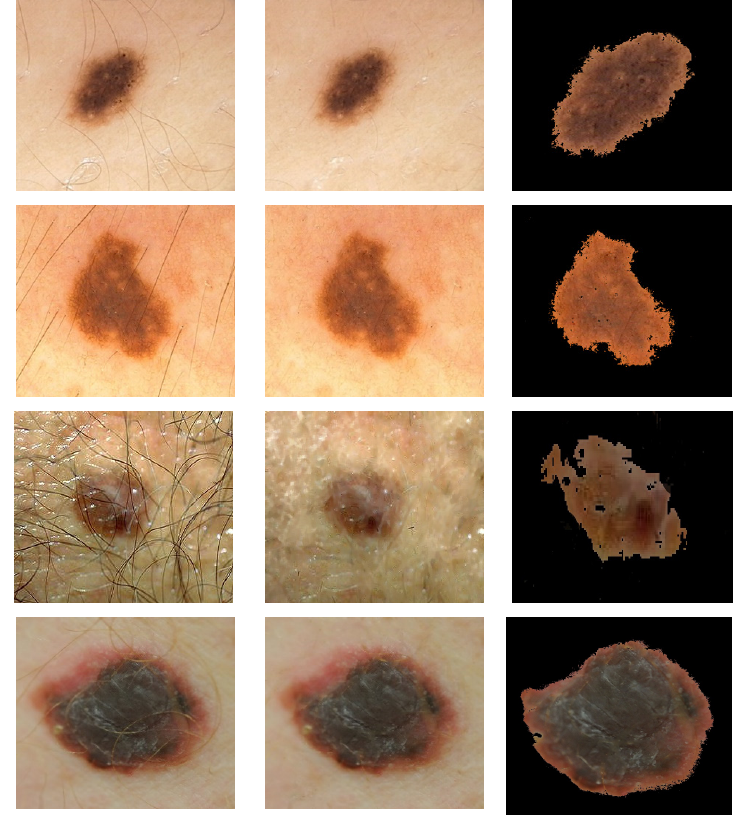
Figure 2. Illustration of pre-processing for hair removal and segmentation. Rows 1 and 2: nevi image (PH2 database). Rows 3 and 4: melanoma image (7-Point database in row 3 and Med-Node database in row 4). First column: original image. Second column: image after the hair is removed. Third column: segmented image. Med-Node contains non-dermoscopic (or simple digital) images acquired via cross-polarized light. Skin lesions in PH2 were imaged via polarized noncontact dermoscopy by using conventional cross-polarized light. Skin lesions in 7-Point were imaged via fluid immersion and non-polarized